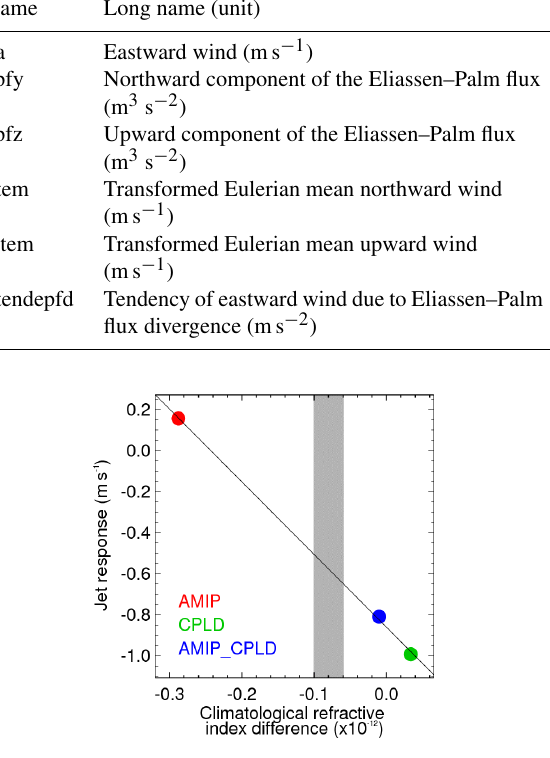
Figure 9. Potential emergent constraint on atmospheric response to Arctic sea ice. Dependence of Atlantic jet response to reduced Arc- tic sea ice on the background climatological refractive index dif- ference between midlatitudes (25–35 ◦ N) and high latitudes (60– 80 ◦ N) at 200hPa. Grey shading shows the observed range from the ERA-Interim and NCEP II reanalyses. The Atlantic jet response is defined as the difference in zonal mean zonal wind at 200hPa over the region 50–60 ◦ N, 60–0 ◦ W between model experiments with reduced and climatological Arctic sea ice. Experiments were per- formed with the same model but with three different configurations: atmosphere only (AMIP); fully coupled (CPLD); and atmosphere only but with SST biases from the coupled model (AMIP_CPLD). An “emergent constraint” is obtained where the observed refractive index difference (grey shading) intersects the simulated response (black line), suggesting a modest weakening of the Atlantic jet in response to reduced Arctic sea ice. Source: Smith et al.